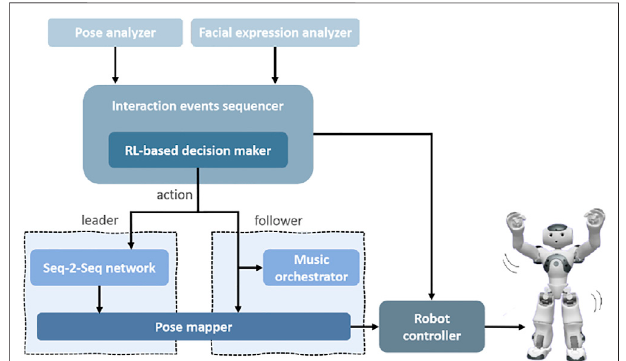
FIGURE 2 | The main system components in our dance interaction design.Theseconsistoftheposeandfacialexpressionanalyzersthatprocess behavioral cues from the user. The interaction events sequencer executes all the steps in our interaction design, within which the RL-based decision maker uses the behavioral data to determines the best robot action. The S2S network generates the robot dance sequences in the leader mode and the observed user pose data is used directly to create the follower mode robot movements and musical output. The pose mapper creates a mapping of